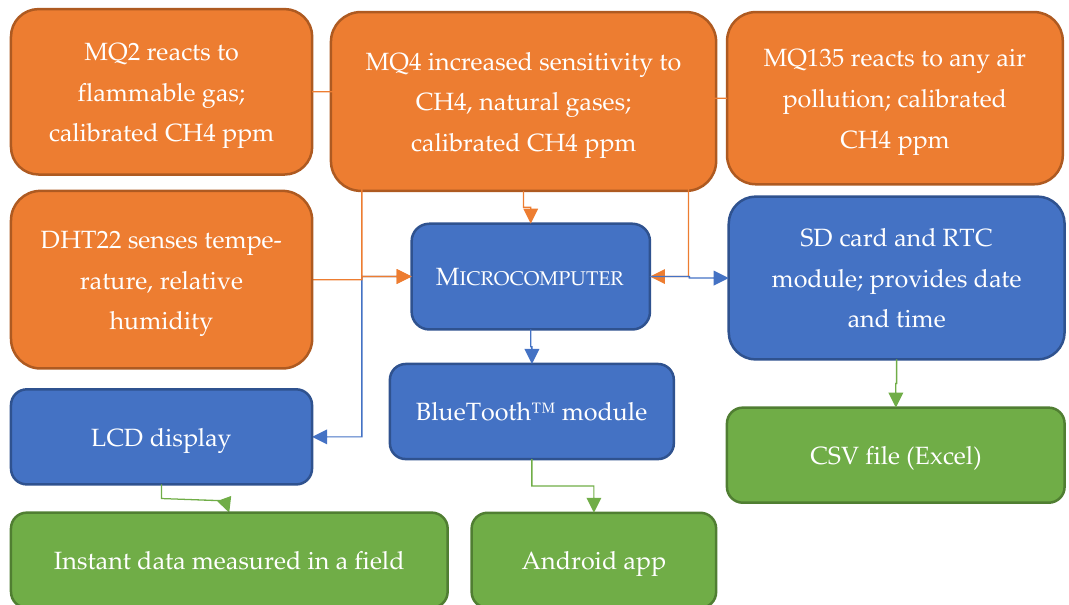
Figure 2. Schematics of interactions between the main components of the gas sensor system: gas sensors (orange), hardware for processing and output (blue), real time and saved results (green).